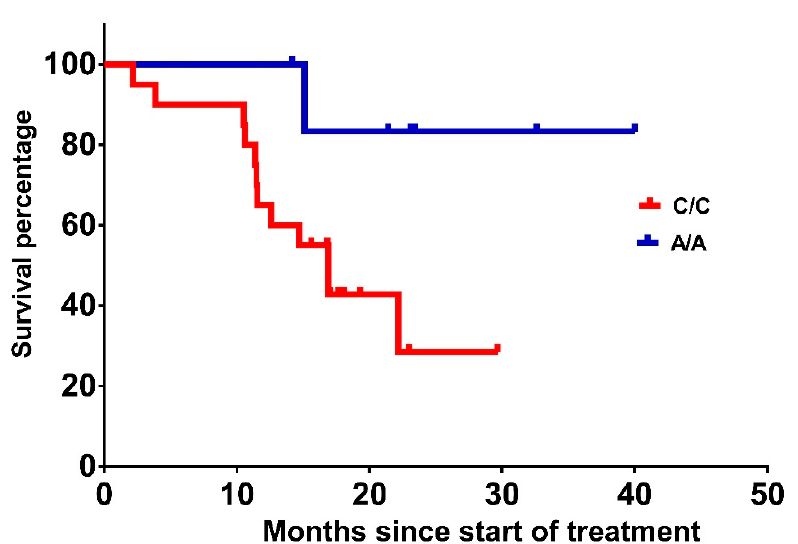
Figure 2. OS from treatment initiation of patients with VEGF-A rs699947 A/A vs. C/C (52 vs. 18.1 months, p =